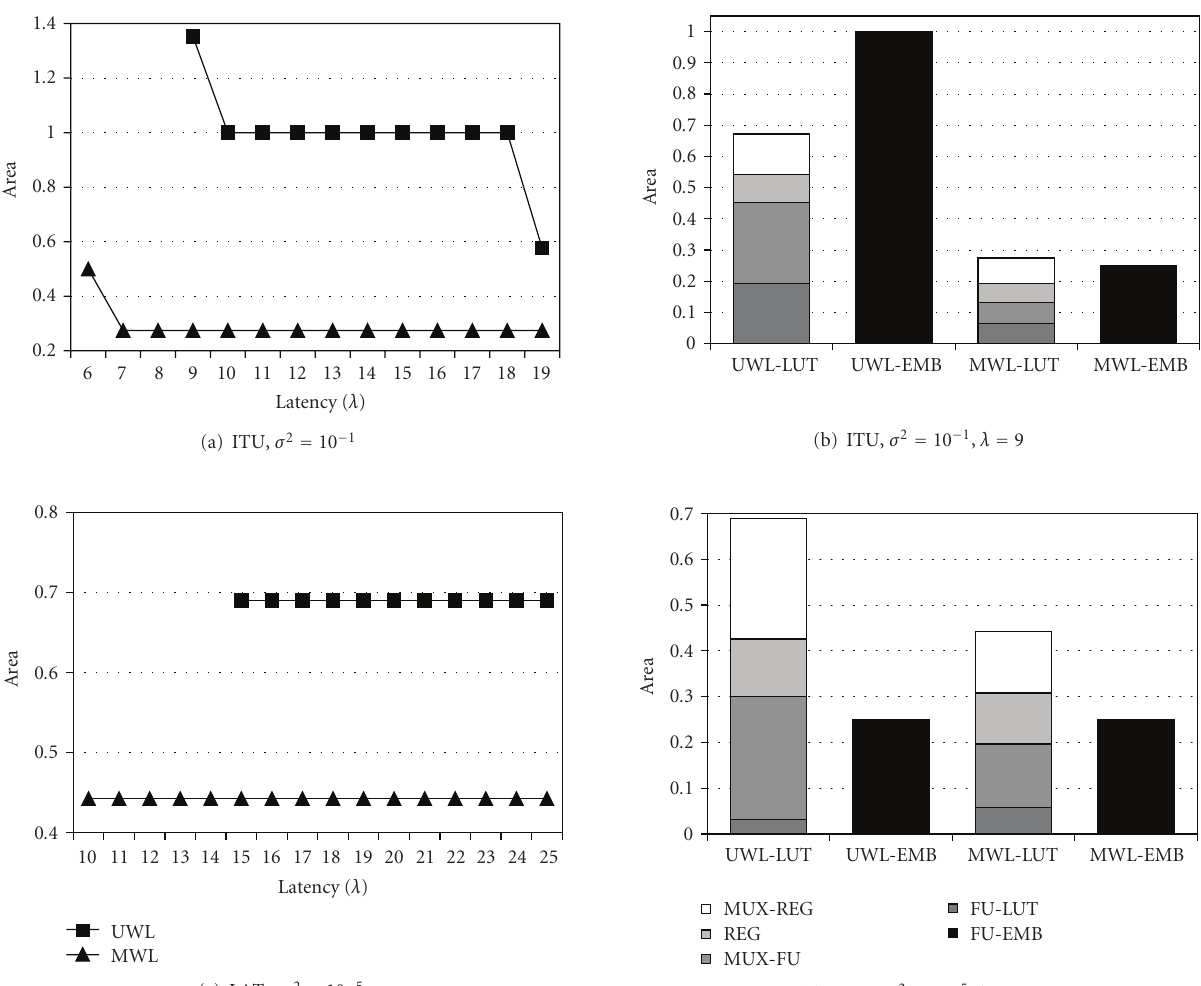
Figure 6: UWL versus MWL: homogeneous implementations